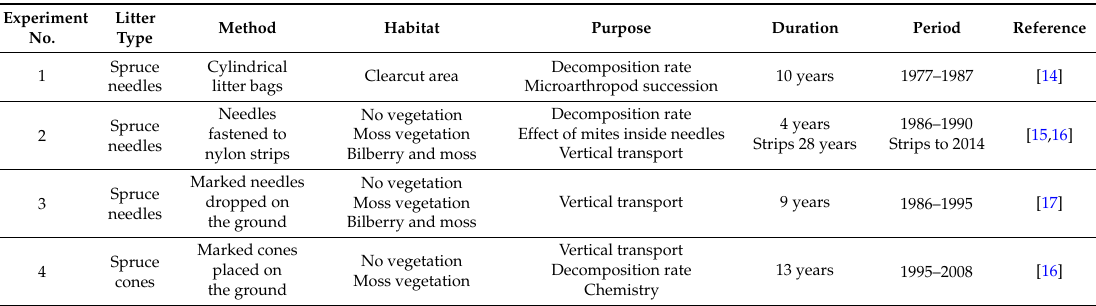
Table 1. Key information on four long-term experiments on the decomposition and vertical transport of spruce needles and cones in a podzol soil profile. Experi ‐ ment No.